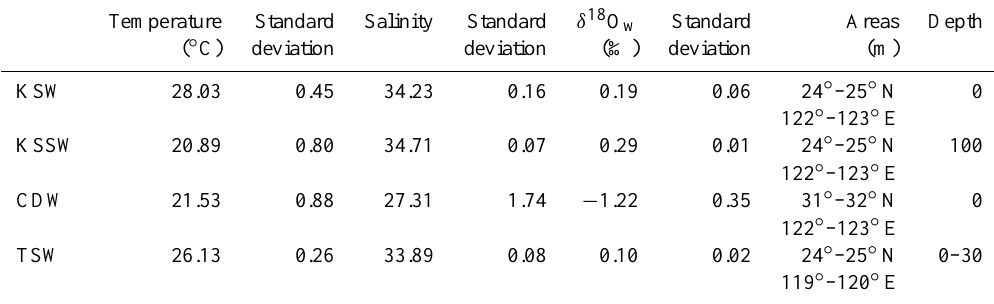
Table 1. Modern temperature, salinity, and δ 18 O w values for water masses averaged from June to October in a 1 ◦ × 1 ◦ box noted in the column “Areas”. Data are from monthly mean data statistically processed by the Japan Ocean Data Center. δ 18 O w values are converted from salinity values using the present-day relation equation δ 18 O w = 0.203 S –6.76 by Oba